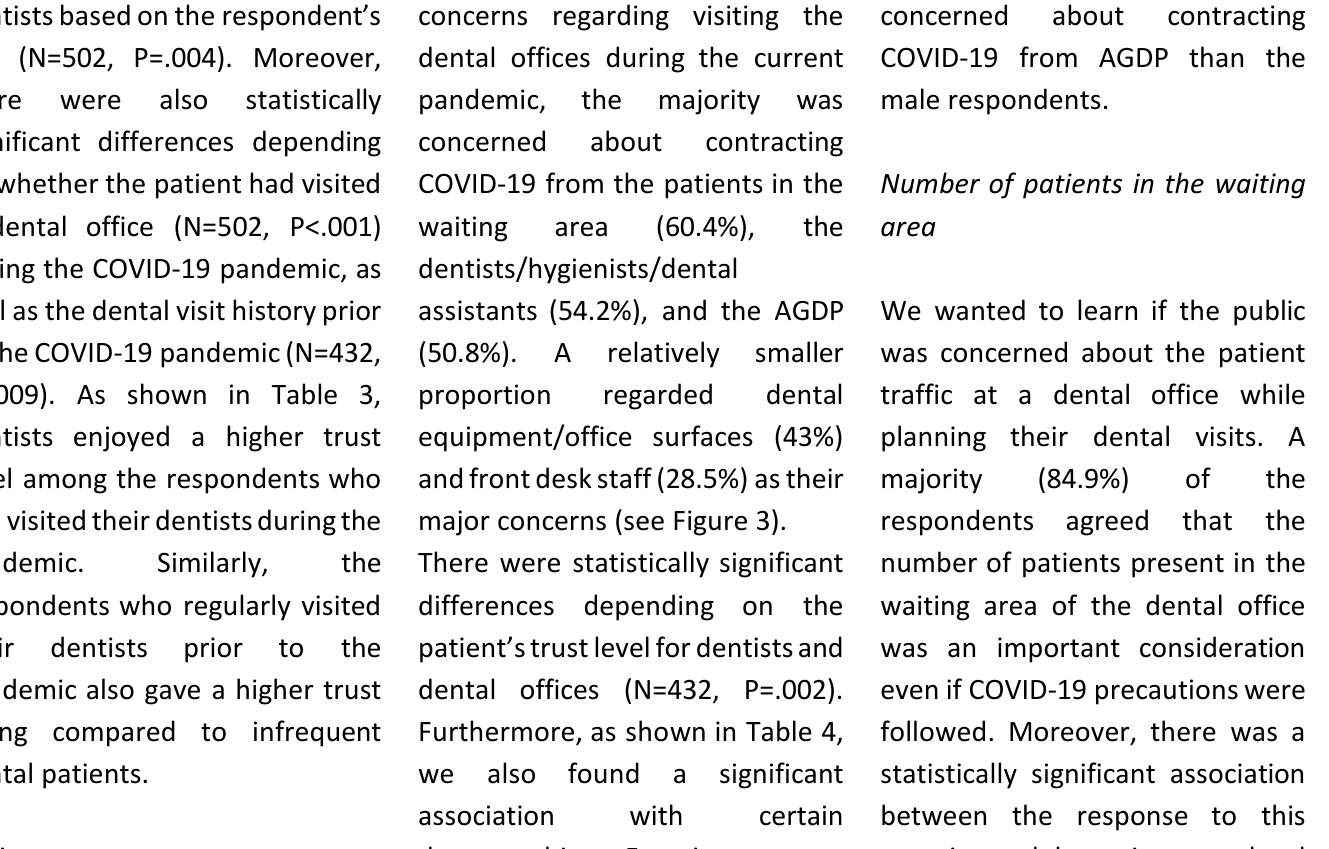
Figure 3 Patients’ chief sources of concern about contracting COVID-19 during a dental